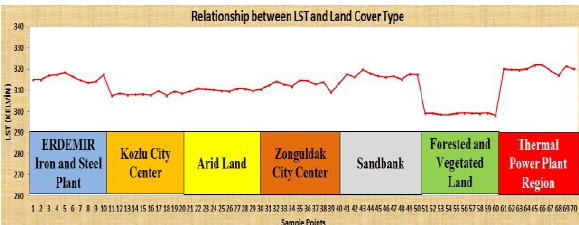
Figure 5. Relationship between LST and land cover types Accuracy assessment of LST image was conducted using the linear correlation coefficient between the radiance and LST values. In general, the temperature values of LST image and local meteorological stations are compared for this